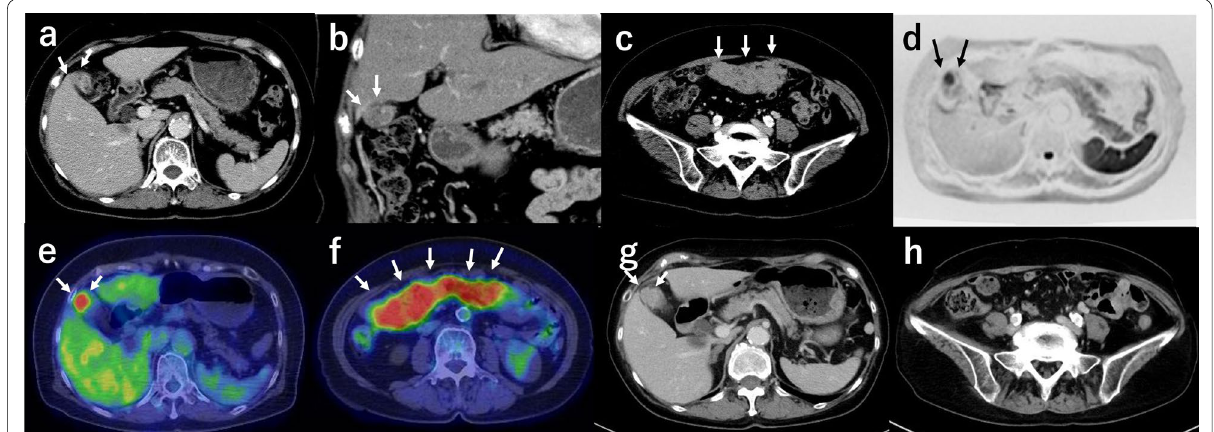
Fig. 1 a , b , c Initial abdominal enhanced computed tomography (CT) in axial ( a ) and coronal ( b ) sections showed thickening with contrast enhancement of the gallbladder fundus (arrows) and multiple nodules in the peritoneal cavity ( c ). d Diffusion-weighted magnetic resonance imaging showed diffusion impairment at the primary tumor (arrows). e , f PET-CT showed high maximum standardized uptake values for the gallbladder tumor ( e ) and other nodules ( f ) (arrows). g , h After chemotherapy, abdominal CT showed that the primary tumor had enlarged slightly ( g ) (arrows), but that the peritoneal nodules had disappeared in some areas and had not increased in number ( h